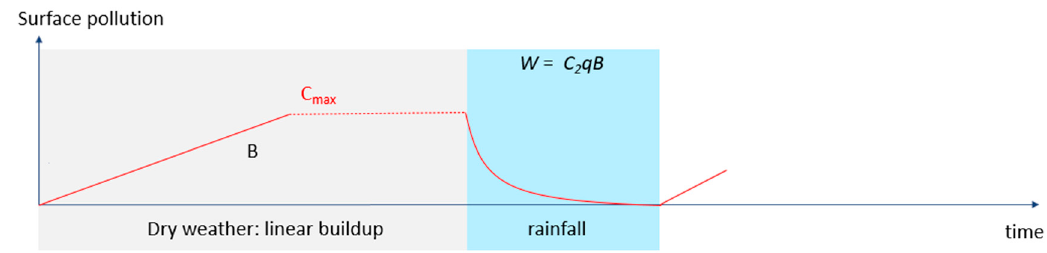
Figure 2. Scheme of the build-up/wash-off model.